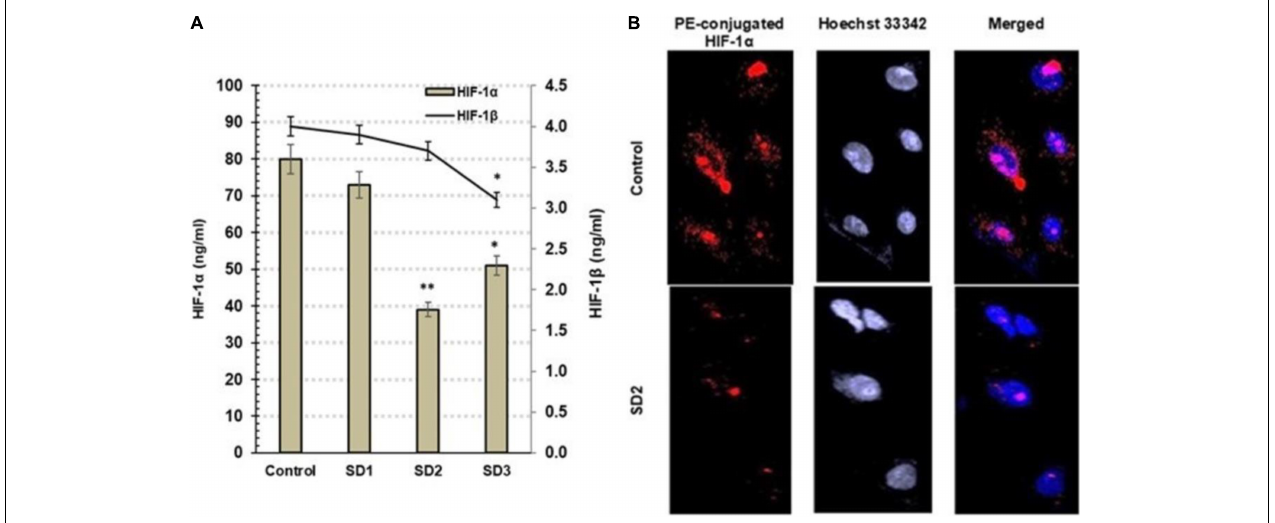
FIGURE 4 | (A) Estimation of HIF-1 α and HIF-1 β by ELISA in CAL-27 cells after being treated with 30% of IC 50 of each extract fraction for 48 h, compared to control cells, after 48 h. Data are expressed as (mean ± SD in ng/ml, n = 6). ∗ p < 0.05, and ∗∗ p < 0.01 compared with the corresponding control. (B) SD2 treatment led to an inhibited HIF-1 α ; the immunocytochemical staining was implemented by a PE-conjugated HIF-1 α antibody (red) and the nuclei counterstaining with DAPI (blue). SD2-treated cells showed a lower HIF-1 α concentration than control. The cells were analyzed under fluorescence microscope (magnification ×